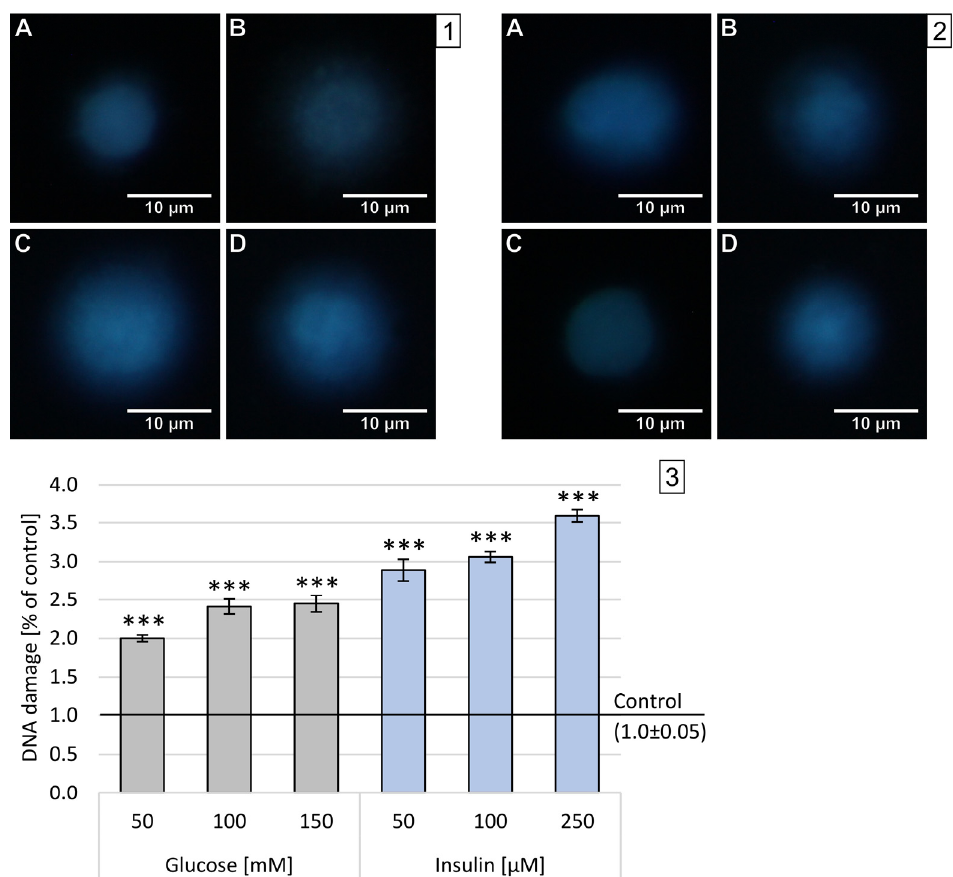
Figure 4. Analysis of double-stranded DNA breaks in neuron-like cells after 1 h incubation with glucose or insulin. ( 1 ) Sample microphotographs of a nuclear diffusion halo: A—control (untreated cells), B—glucose 50 mM, C—glucose 100 mM and D—glucose 150 mM. ( 2 ) Sample microphotographs of nuclear diffusion halo: A—control (untreated cells), B—insulin 50 µM, C—insulin 100 µM and D—insulin 150 µM. ( 3 ) A comparison of relative NDF for neuronal-like cells incubated for 1 h with glucose or insulin. Statistically significant differences compared to the untreated neuron-like cells: *** p <